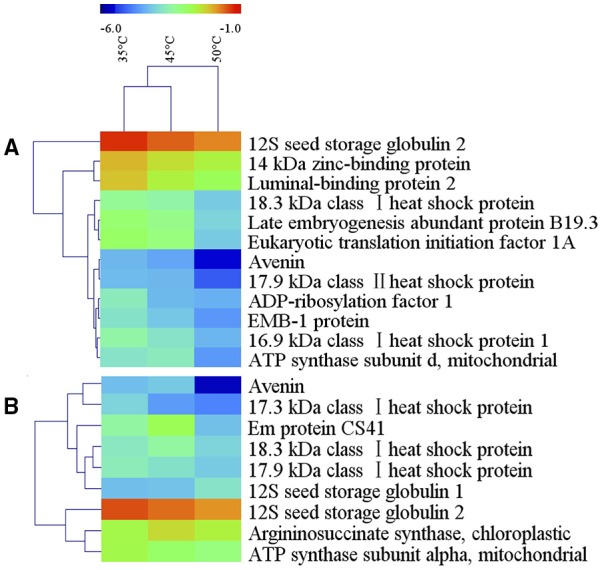
Hierarchical cluster analysis of heat-resistance proteins in oat seeds with 10 and 16% MC. Dataset clustering was performed with MeV software after log2 transformation of the expression abundance values. Each colorized cell represents the spot quantity, according to the color scale at the top of the figure. (A, 10% MC; B, 16% MC).